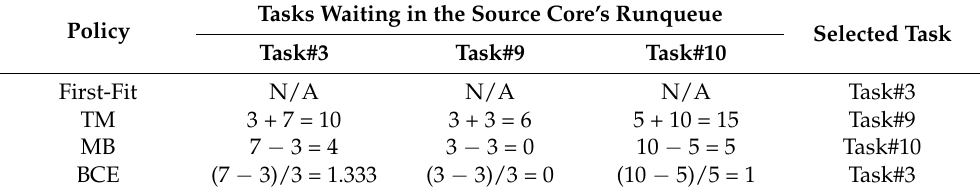
Table 1. Selecting a task using different selection